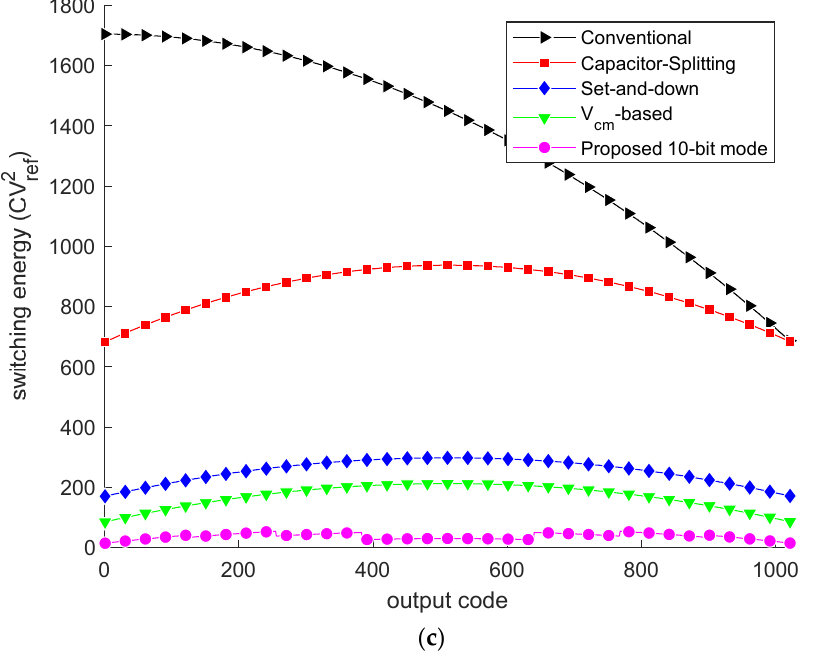
Figure 6. Switching energy against output codes: ( a ) 8-bit; ( b ) 9-bit; ( c ) 10-bit. The black [12], red [9], blue [10], green [11] and magenta curves in the three figures are switching energy. Table 5. Comparison of several switching schemes for SAR